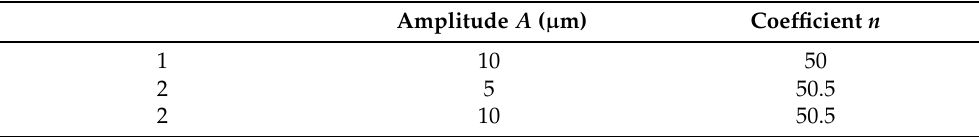
Table 2. The x -axis motion parameters used in the